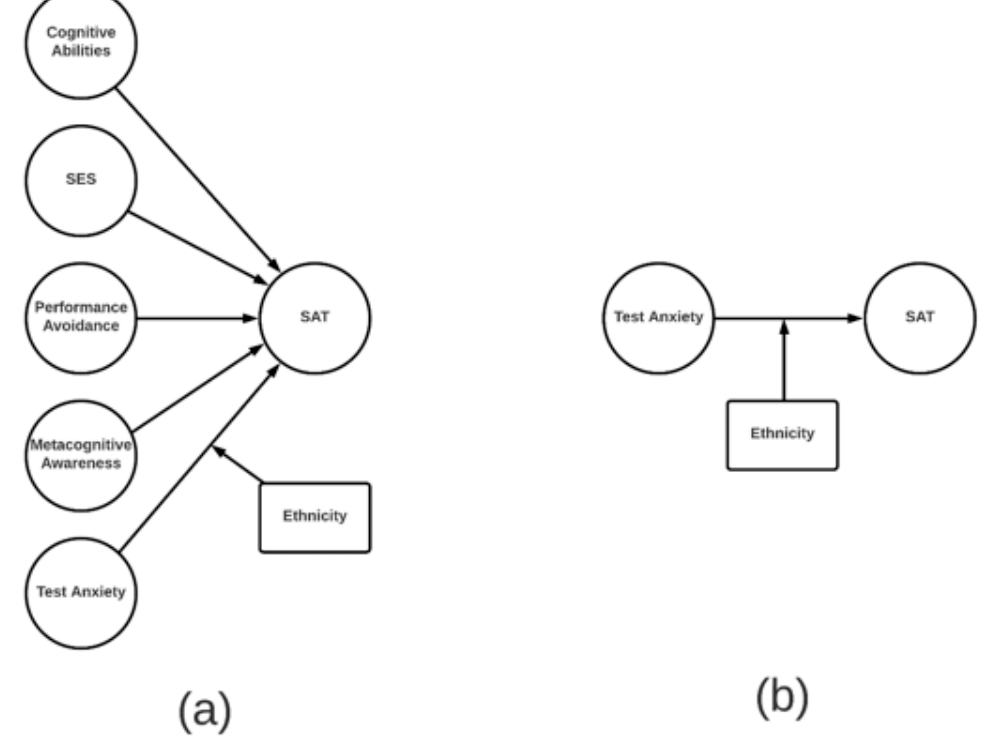
Figure 2. The theoretical di ff erence between the regression results in Hannon (2019) Table 3 and the visualizations in Hannon (2019) Figures 1 and 2. Left panel ( a ) demonstrates the regression results and right panel ( b ) demonstrates what was plotted in Figures 1 and 2. SES refers to Socioeconomic Status.